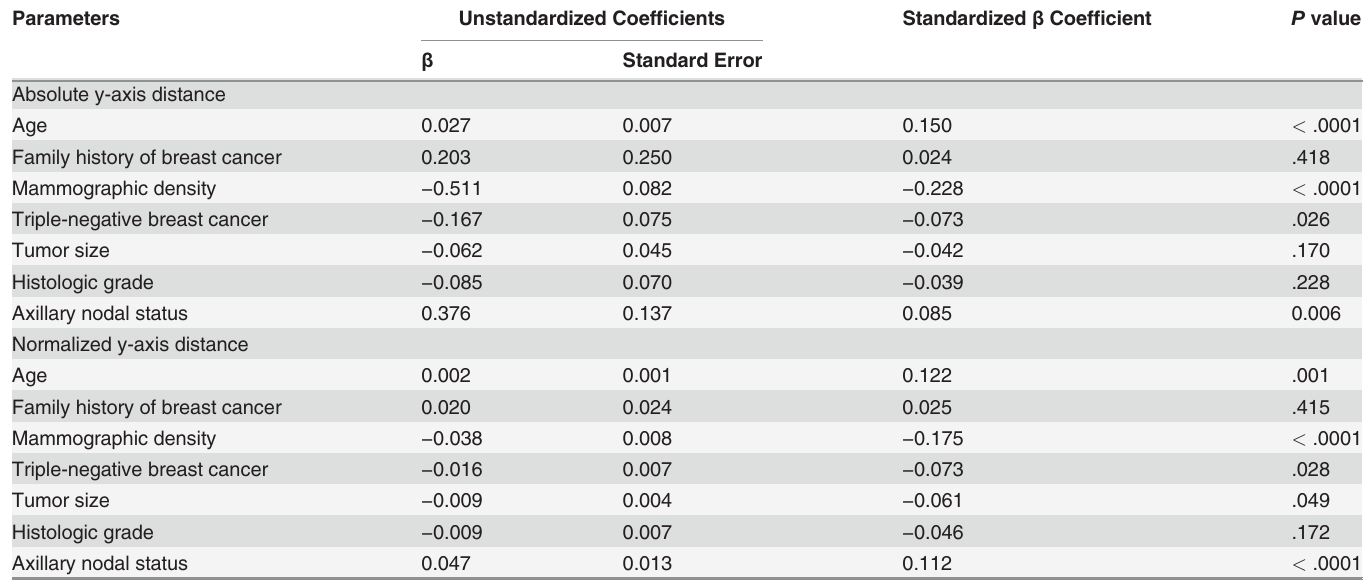
Table 4. Multiple Linear Regression Analysis of Association of Variables with Distance from the Chest